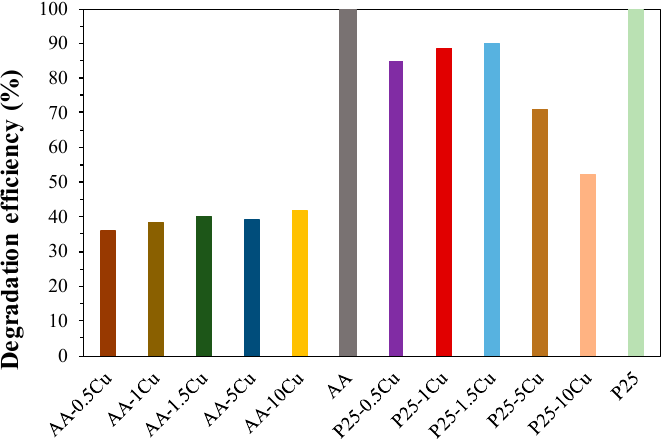
Figure 6. Degradation of ketoprofen under the irradiation of UV light—some of the composites achieved better activity than the base catalyst but only in the case of P25.